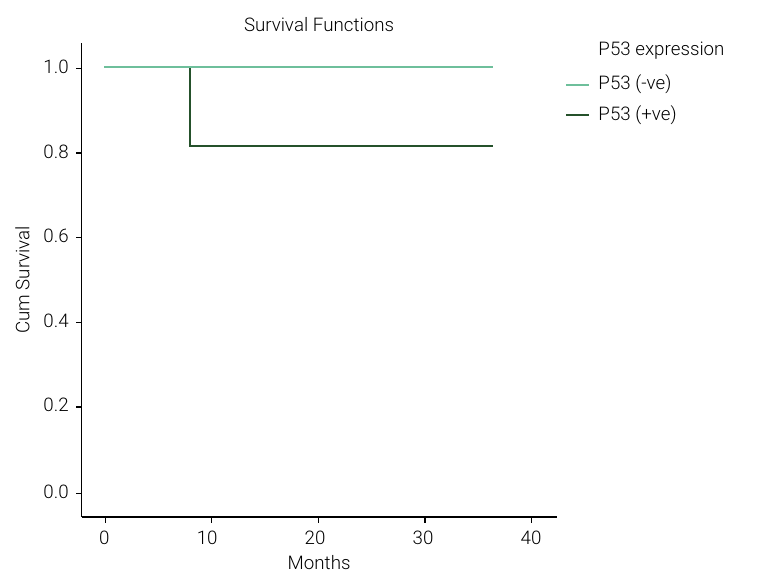
Figure 4. Cumulative local recurrence free survival curve for p53 expression in resected surgical